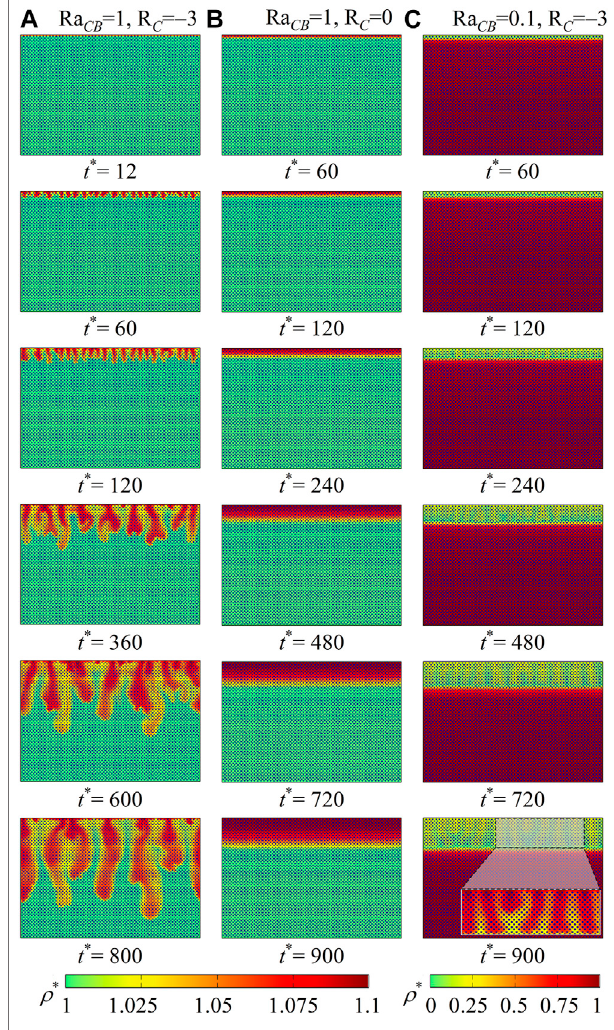
FIGURE6| Densitycontours ρ *atsixtimeinstantsforcaseswithRa AB (cid:2) 0.1andR A (cid:2) 0and (A) Ra CB (cid:2) 1,R C (cid:2)− 3, (B) Ra CB (cid:2) 1,R C (cid:2) 0,and (C) Ra CB (cid:2) 0.1, R C (cid:2) −